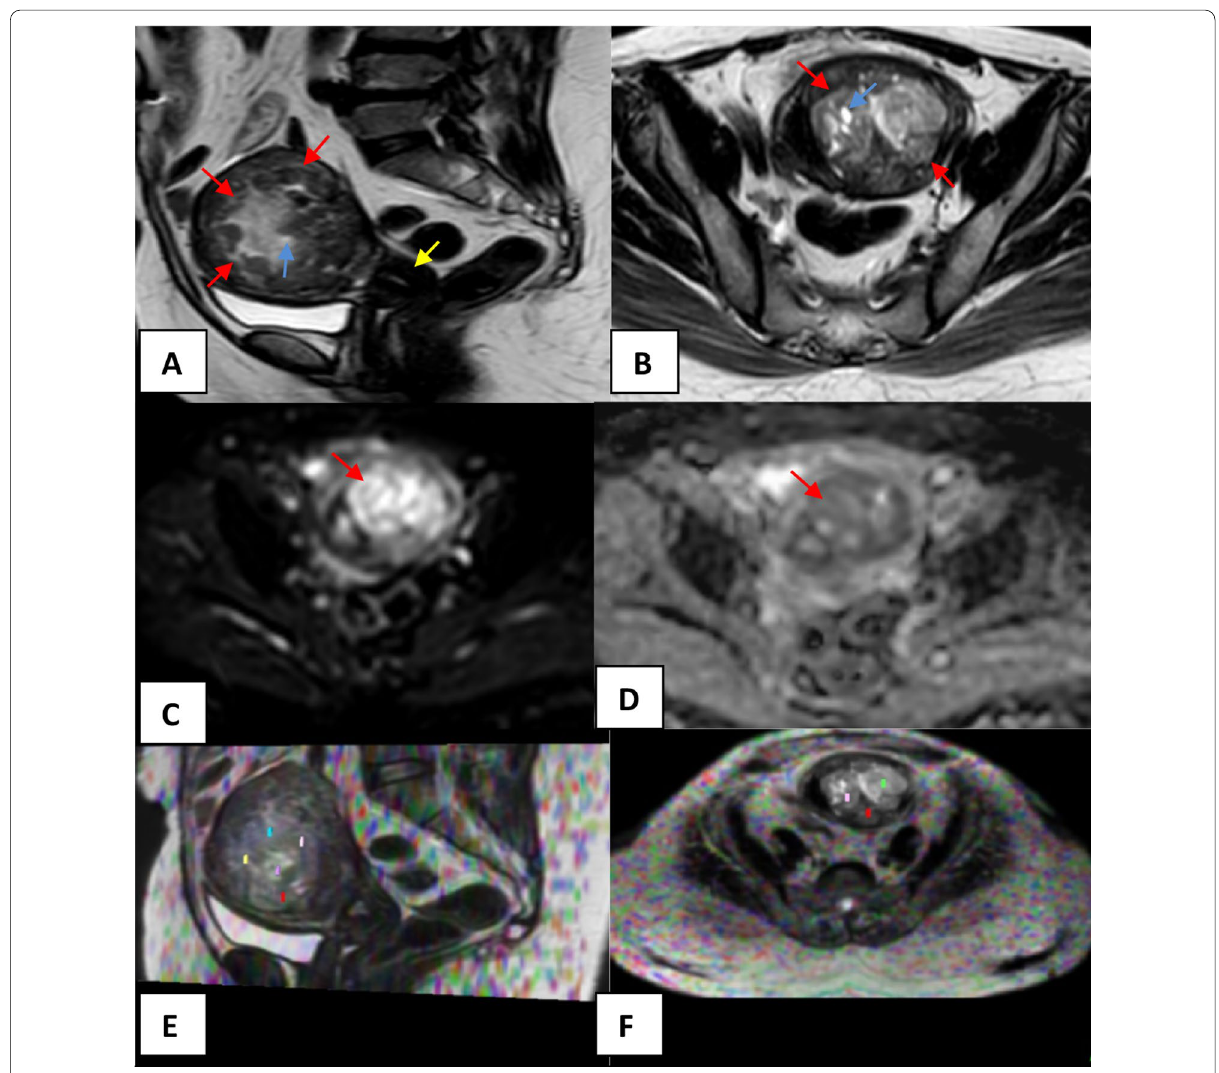
Fig. 8 A 51‑year‑old postmenopausal female presented by menorrhagia and pelvic pain. A , B Sagittal and axial T2 WIs occupation of the endometrial cavity by a poorly defined large oval‑shaped polypoidal soft‑tissue mass displaying heterogeneous SI and infiltrating the uterine body (red arrow). The mass has foci of high SI due to necrosis (blue arrow). No cervical extension (red arrow). C Axial DWI with b value of 1000 s/mm 2 high SI of the endometrial soft‑tissue mass (yellow arrow). D Axial DW-ADC map image low signal intensity of the endometrial soft‑tissue mass (red arrow). Mean DW‑ADC value of the mass 0.898 10 − 3 mm 2 /s. Mean DW‑ADC values at areas of intact and infiltrated myometrium = × 0.912 10 − 3 mm 2 /s, respectively. E , F Sagittal and axial DTI map images values of DT‑FA and DT‑MD in multiple ROI. Mean DT‑FA and DT‑MD values × of the endometrial mass 0.143 and 0.415 10 − 3 mm 2 /s, respectively. Mean DT‑FA and DT‑MD values at areas of infiltrated myometrium = × and 0.478 10 − 3 mm 2 /s, respectively. Mean DT‑FA and DT‑MD values at areas of intact myometrium × Diagnosis Pathologically proved endometrial stromal